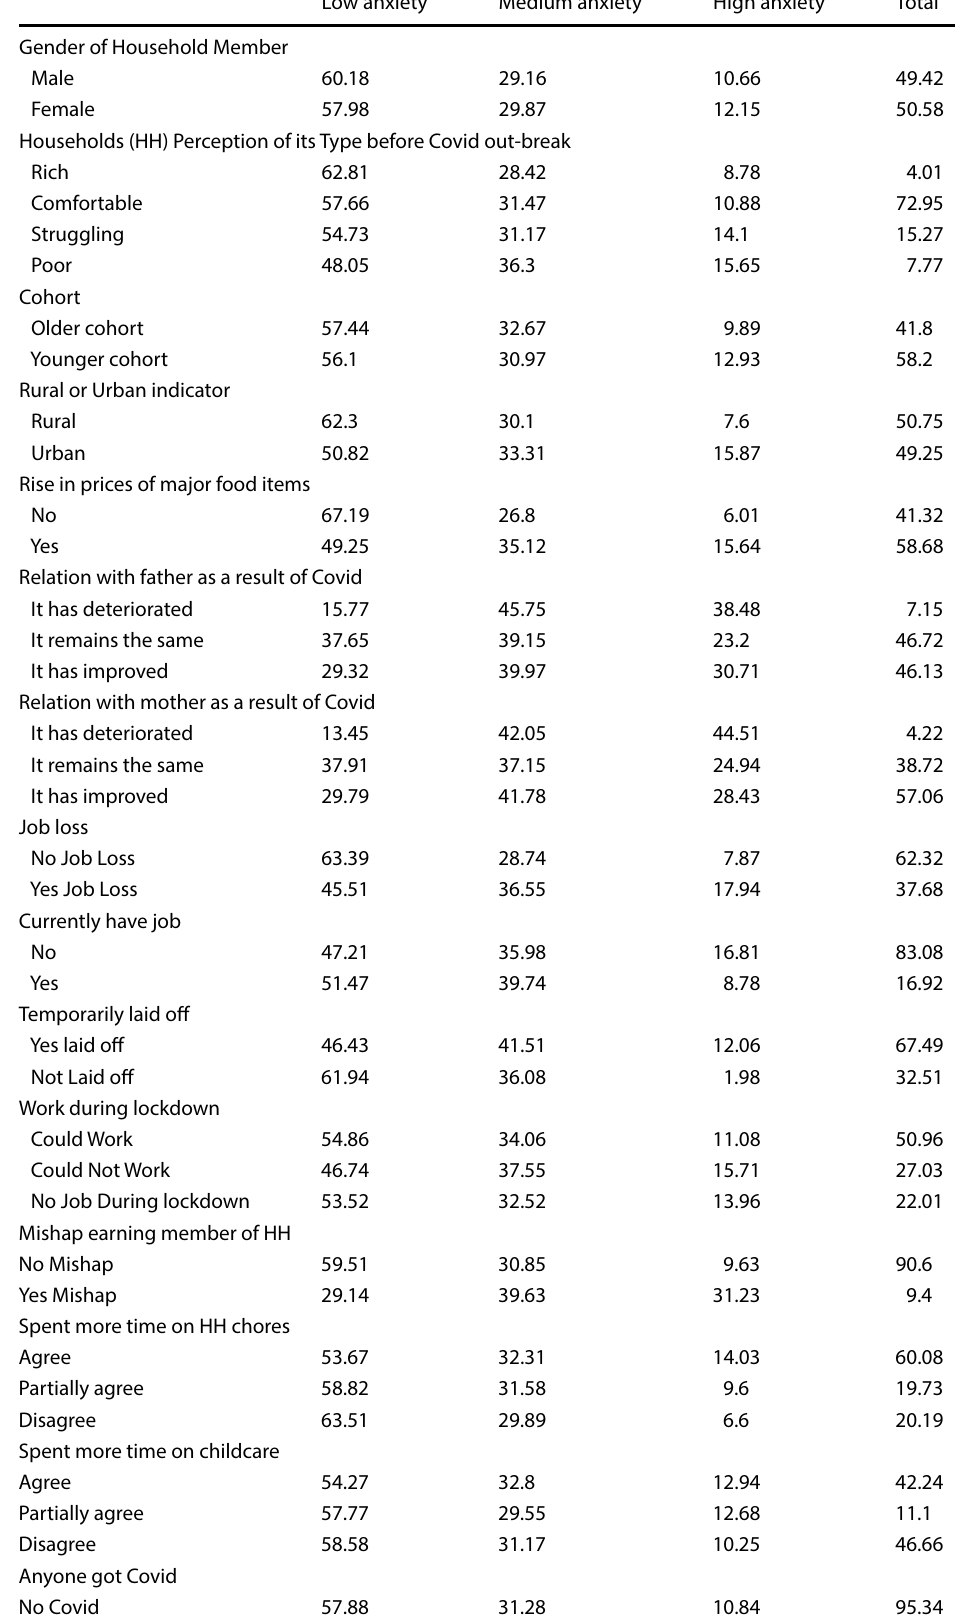
Table 1 Distribution of anxiety with respect to key